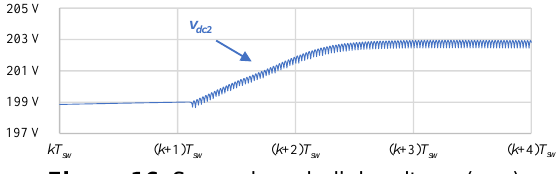
Figure 16. Secondary dc-link voltage ( v dc2 ) regulation considering an EPS